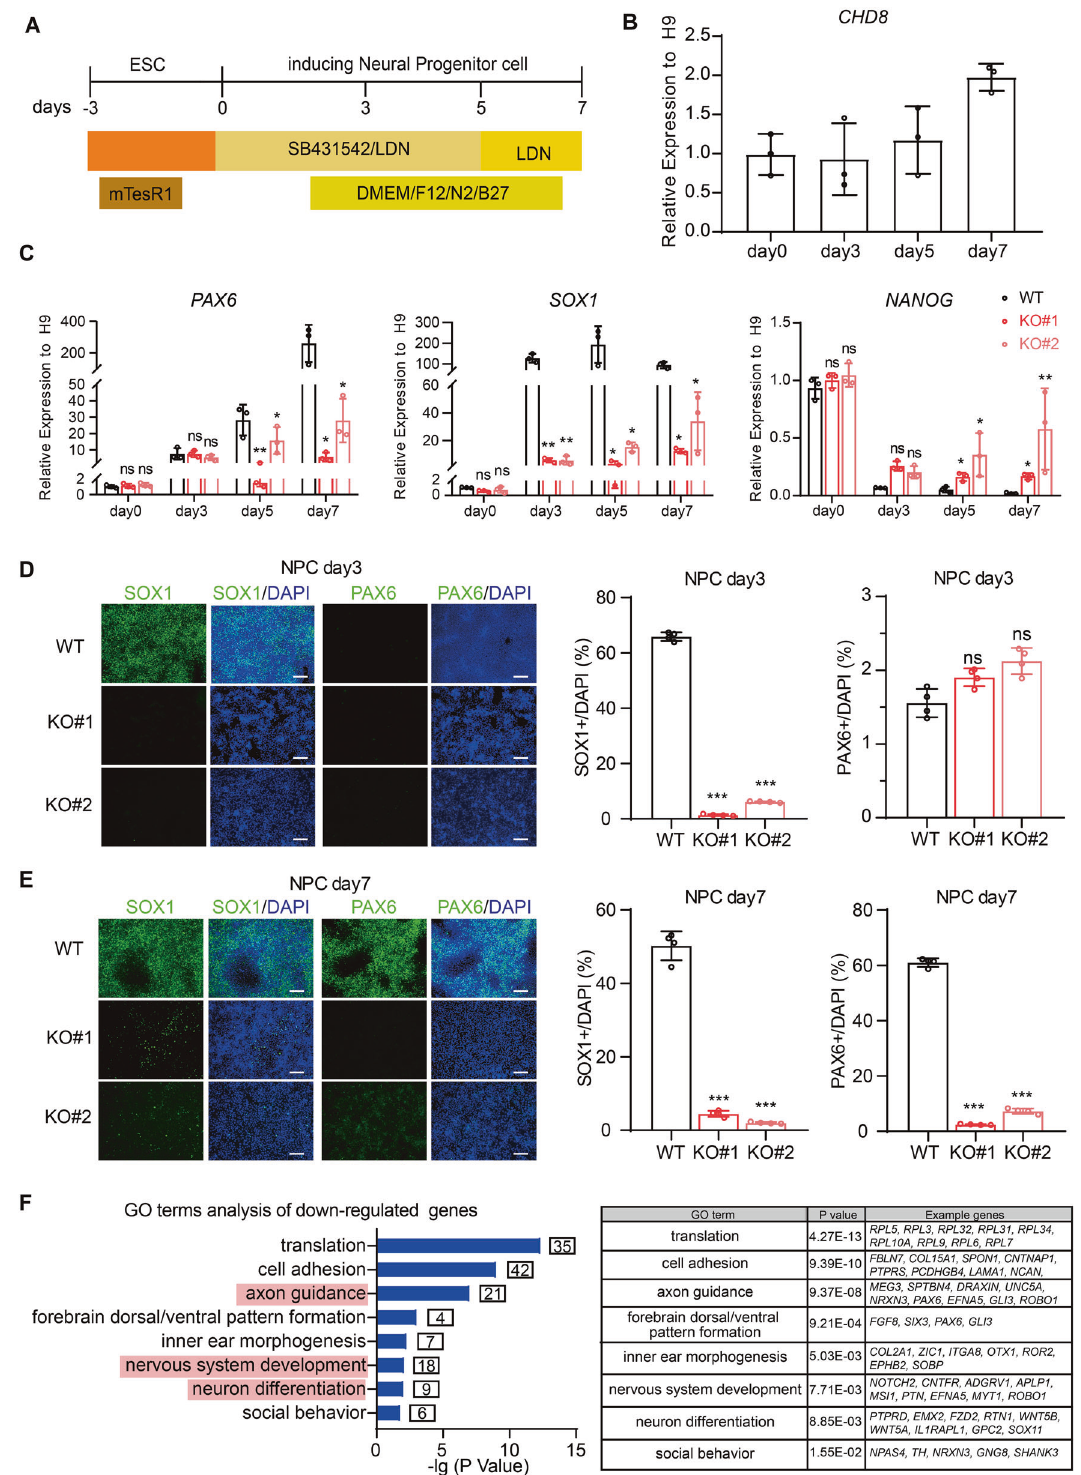
Fig. 5 CHD8 loss-of-function disrupts neuroectoderm differentiation. A Cartoon schematic showing the protocol of differentiating human ESCs toward neural fate. B the dynamic gene expression of CHD8 during neuroectoderm differentiation ( n = 3). C RT-qPCR analysis of neuroectoderm genes PAX6 and SOX1 and pluripotent gene NANOG at day 0, 3, 5, 7 of differentiation ( n = 3). Wildtype ESCs at day 0 served as control. D , E Immuno fl uorescence of neuroectoderm markers SOX1 and PAX6 in wildtype and knockout groups at day 3 ( D ) and day 7 ( E ) of differentiation. The percentage of SOX1- or PAX6-positive cells was calculated ( n = 4). Scale bar = 200 µm. F GO enrichment analysis for downregulated genes in CHD8 knockout NPC ( P < 0.05, log 2 (fold-change) < − 1). The error bars represented the mean ± SD and the signi fi cance level was calculated by Student ’ s t -test (two-tailed, equal variance) (ns means not statistically signi fi cant, * P < 0.05, ** P < 0.01, *** P < 0.001).